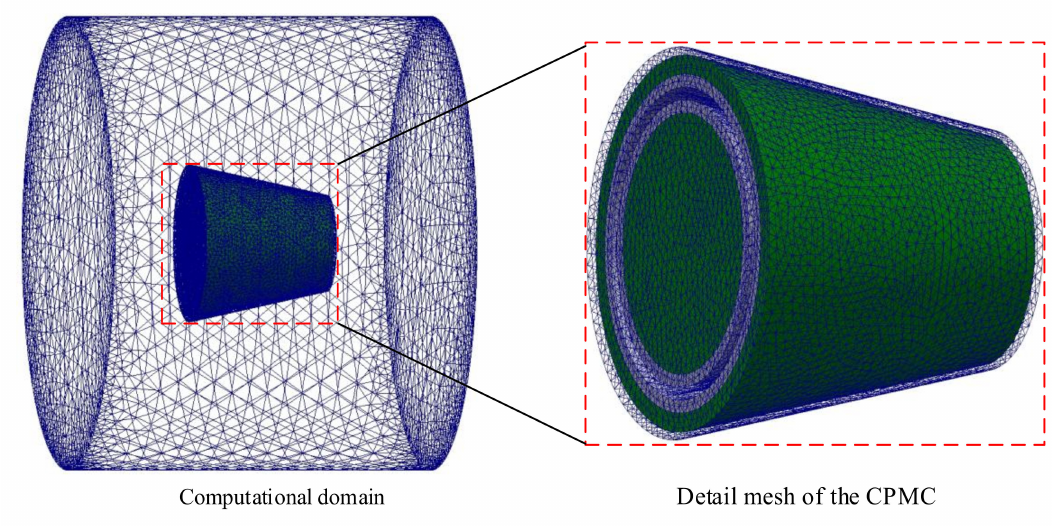
Figure 3. Mesh diagram of CPMC.